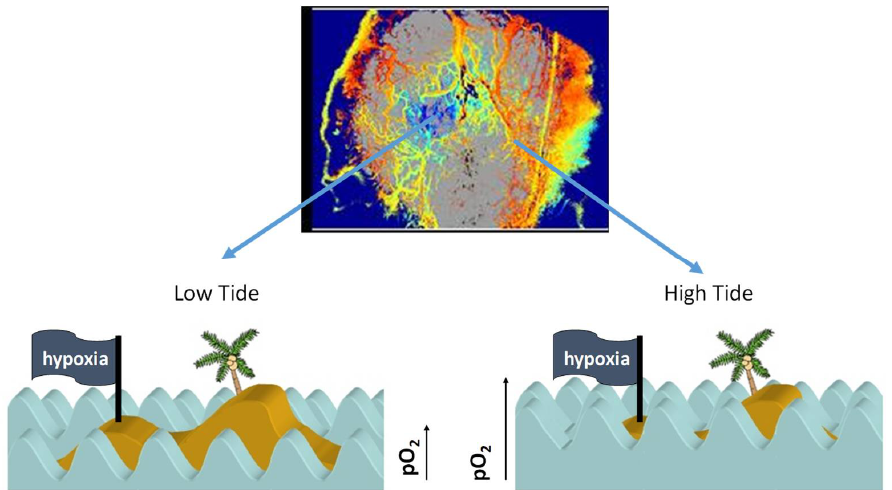
Figure 2. Tides and waves provide an analogy to the kinetics of cycling hypoxia. As depicted in Figure 1, the slow (quasi-steady state) fluctuations in tissue pO 2 , that occur over hours are analogous to tides. ( Upper panel). Map of hemoglobin saturation across a tumor growing in a window chamber (blue = low saturation, orange to red = high saturation). The faster cycles, occurring 2–5 times per hour are analogous to waves. ( Lower Left ) In a region where the steady state pO 2 (tide) is low, the higher frequency fluctuations (waves) in oxygen delivery will lead to fluctuations in the extent of tissue hypoxia, depicted by the island of hypoxia. ( Lower Right ) When the overall oxygen field is high, the waves have less of an influence on the extent of cycling hypoxia. Reproduced from Dewhirst [4] , with permission from the publisher @ 2021 Radiation Research Society.